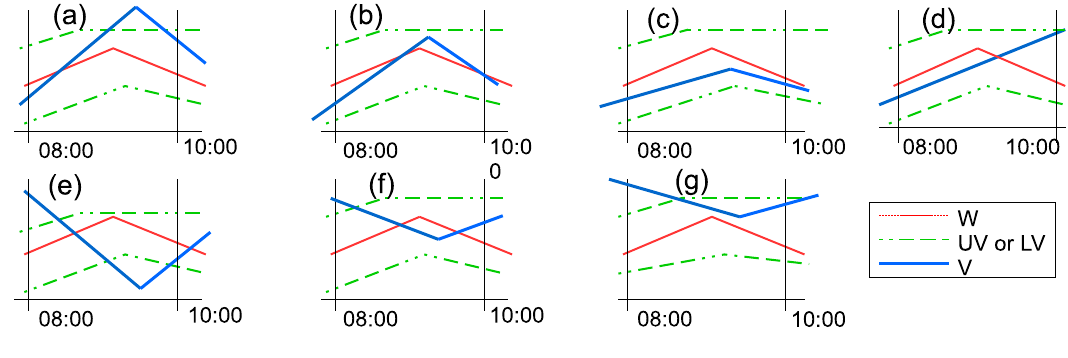
Figure 7. Different peak cases.